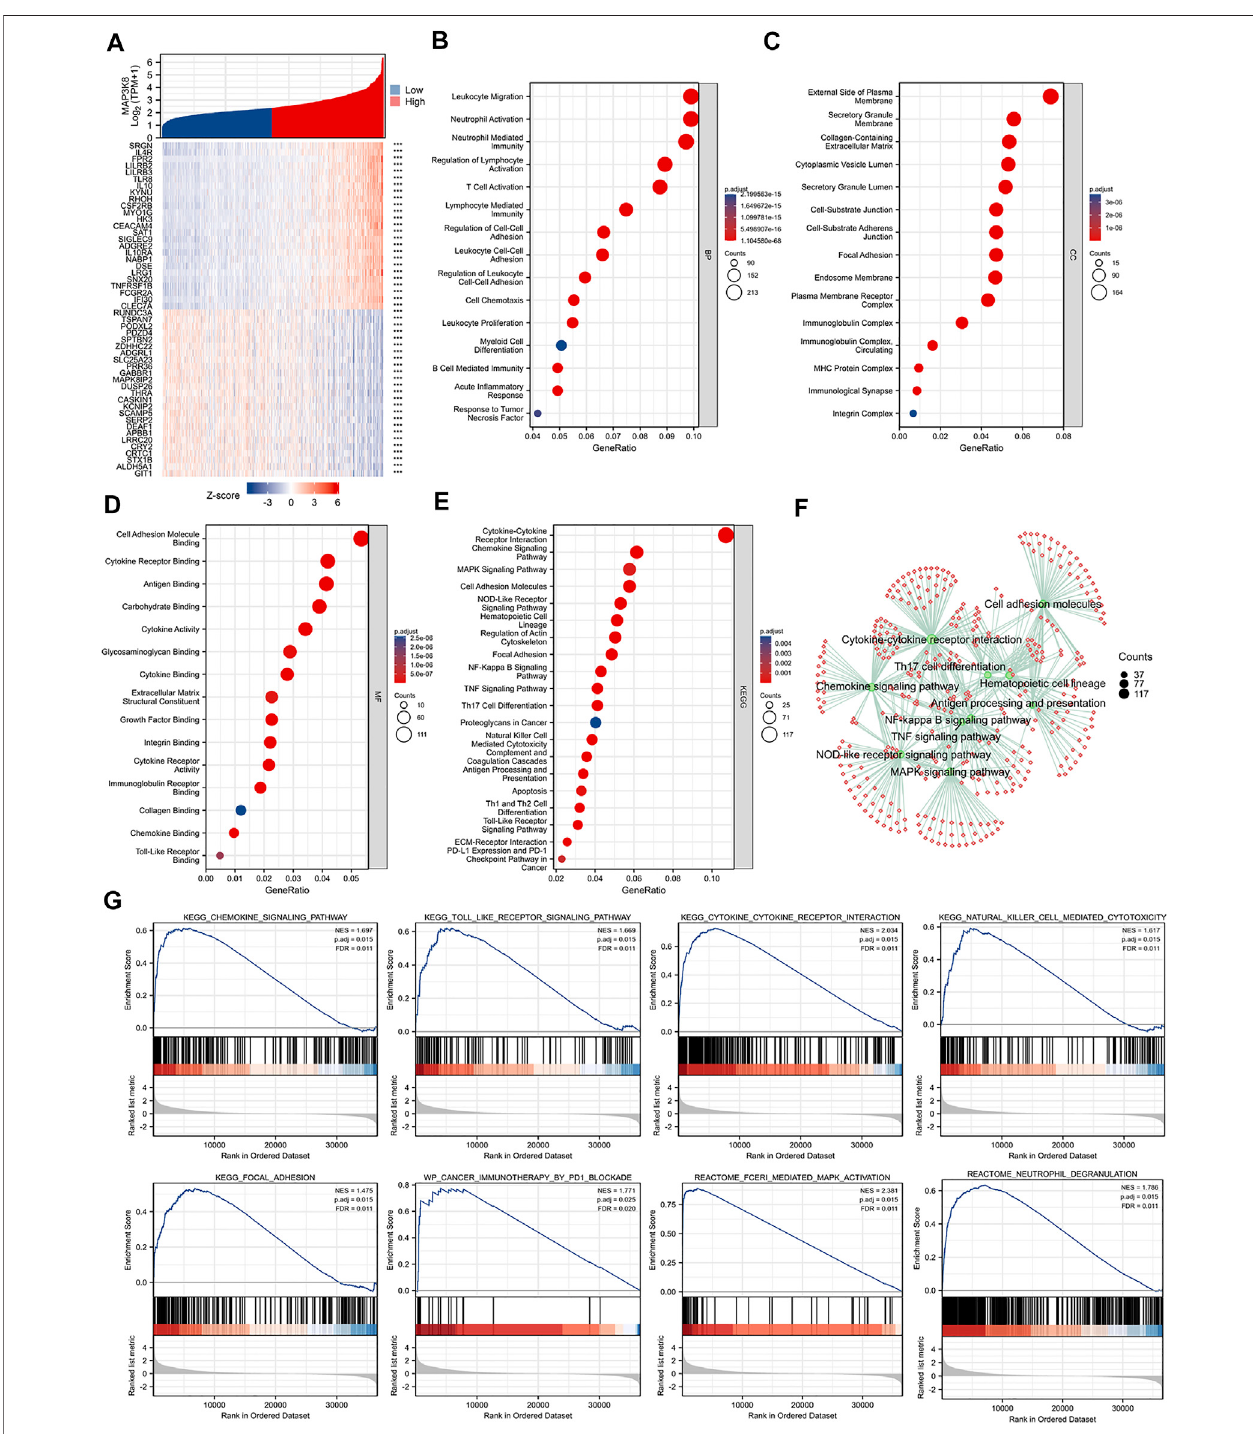
FIGURE4| GeneOntology(GO),KyotoEncyclopediaofGenesandGenomes(KEGG),andgenesetenrichmentanalysis(GSEA)ofMAP3K8inTCGAdataset. (A) Top 25 genes most positively or negatively associated with MAP3K8 shown in a heatmap. (B – D) GO enrichment analysis for biological process (B) , cellular component (C) , and molecular function (D) of MAP3K8 and its co-expression genes. (E , F) KEGG pathway enrichment analysis of MAP3K8 and its co-expression genes. (G) GSEA of MAP3K8 and its co-expression genes.